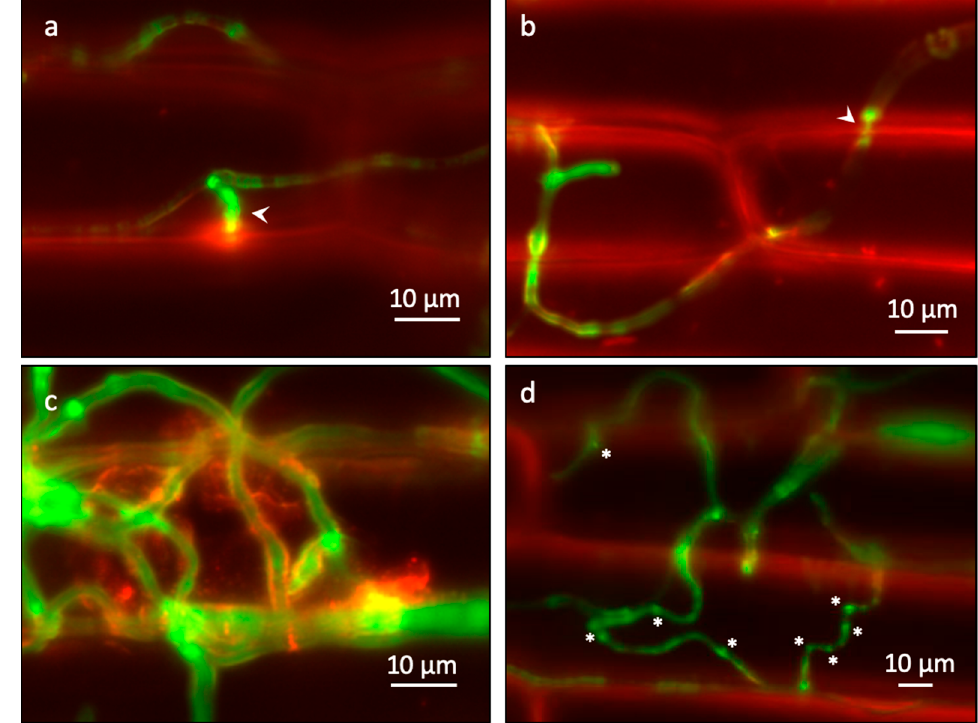
Figure 3. Hyphal structures of Fusarium graminearum on coleoptile epidermal cells. ( a ) The appressoria-like structure of F. graminearum on the mock-treated cells 12 h post inoculation (hpi). The arrowhead indicates an appressorium-like structure. ( b ) The invaded hypha penetrates the neighboring cell of the mock-treated coleoptile 24 hpi. The arrowhead indicates a constricted invasive hyphal peg. ( c ) The invasive hyphae surrounded by the host cell membranes of the mock-treated coleoptile 24 hpi. ( d ) The wandering hyphae on the coleoptile epidermal cells treated with 500 ppm NMN 12 hpi. The asterisks indicate the turning points with slight strong fluorescence.